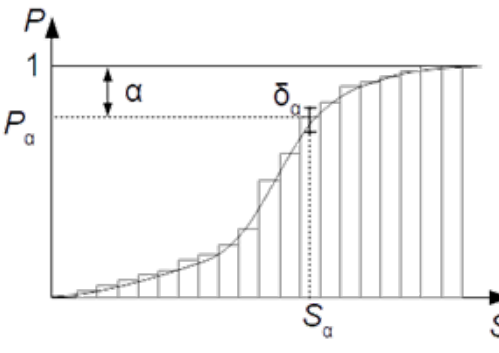
Fig. 5. The probability distribution of the reflected signal